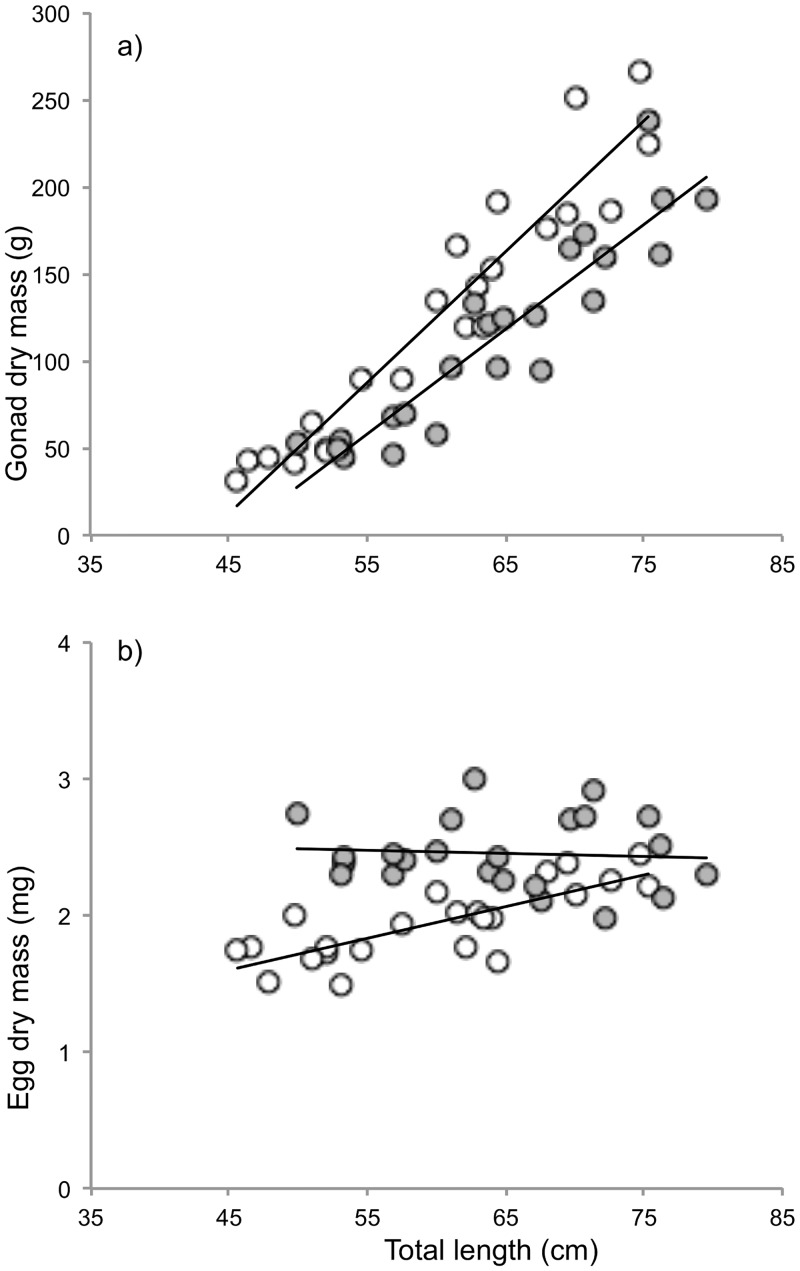
Between population comparisons of Esox lucius female reproductive allocation strategies.a) reproductive effort measured as gonad dry mass as a function of female body size, and b) egg size measured as dry mass per egg as a function of female body size. Every dot represents one individual and the same individuals are represented in both graphs. Grey dots indicate individuals from Okne (n = 23) and open circles indicate individuals from Lervik (n = 23).